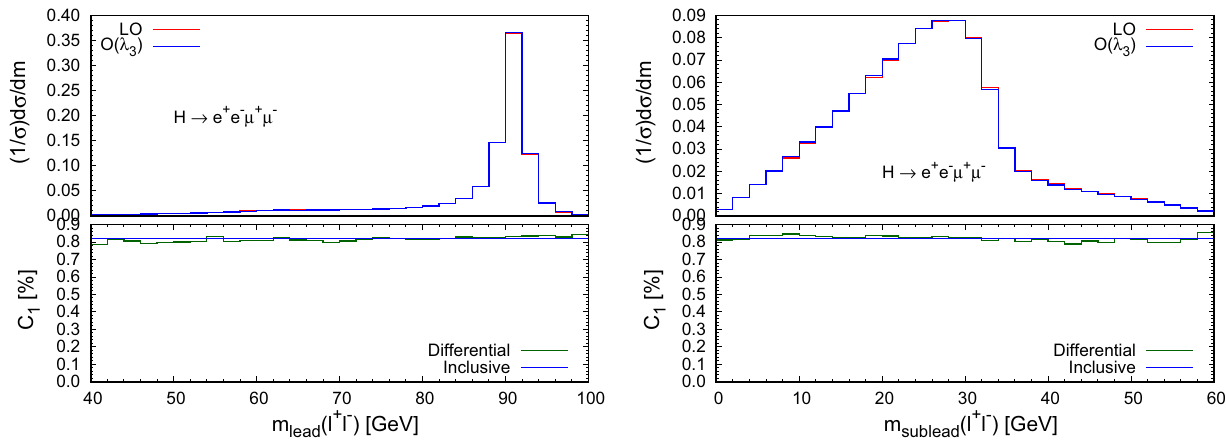
Fig. 7 Leading (left) and subleading (right) OSSF lepton pair invariant mass distributions in H → e + e − μ + μ − . Upper panel: normalized LO (red) and O (λ 3 ) (blue) distributions. Lower panel: C 1 for differential (green) and total decay width